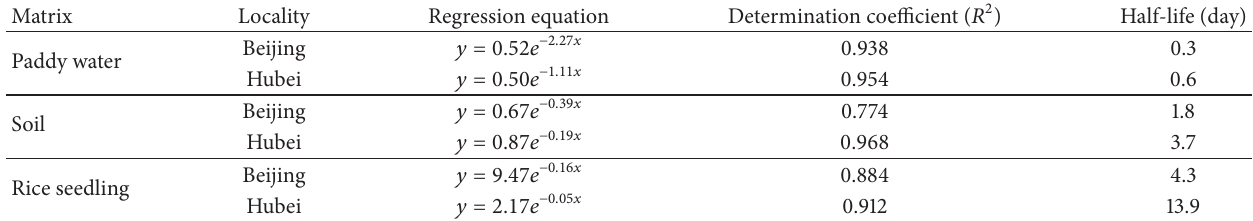
Table 3: The half-lives and dissipation kinetic equations of thifluzamide in paddy (2014).